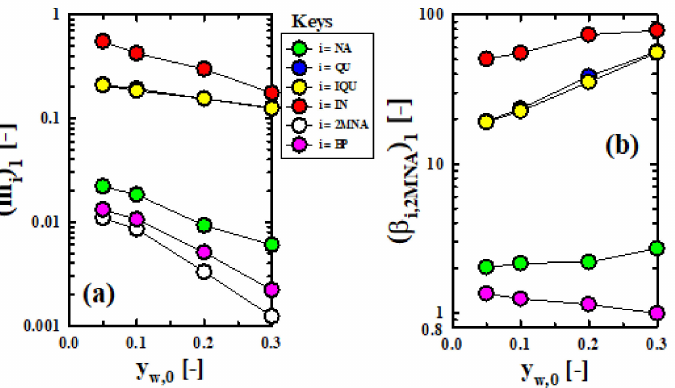
Figure 3. Changes in ( a ) (m i ) 1 and ( b ) ( β i,2MNA ) 1 according to y w,0 . Experimental conditions: S 1 /R 0 = 1, T = 303 K, t = 72